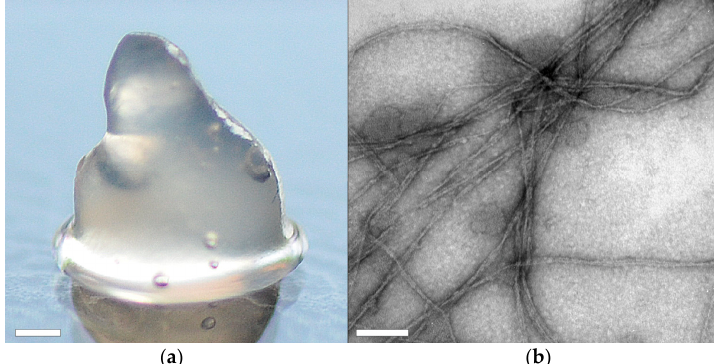
Figure 6. Morphology of a self ‐ assembled ChryC2 hydrogel. ( a ) Photograph of aChryC2 hydrogel. Scale bar: 1 mm; ( b ) Transmission electron microscopy imaging revealed the morphology of the underlying fibrils was 5 nm in diameter. Scale bar: 100 nm.